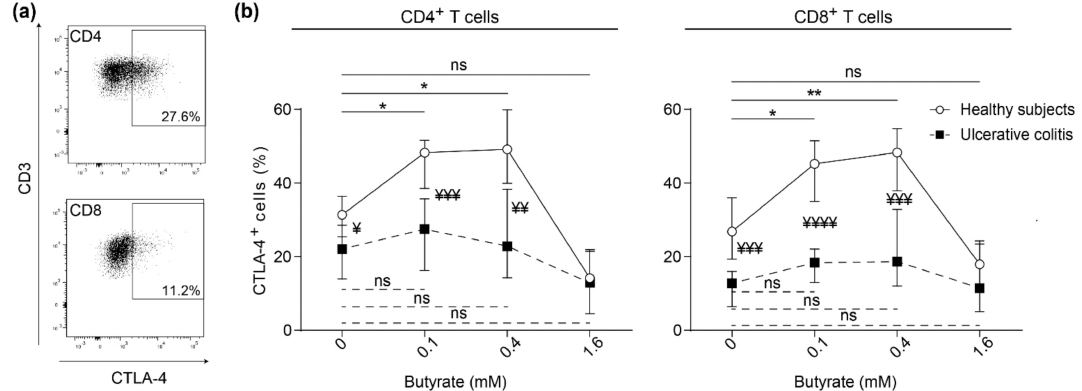
Figure 2. Effects of butyrate on cytotoxic T lymphocyte-associated antigen-4 (CTLA-4) surface expression on blood T cells from healthy subjects and UC patients with active disease. PBMCs were stimulated with anti-CD3 and anti-CD28 with increasing concentrations of butyrate (0–1.6 mM) for 72 h and analyzed by flow cytometry. ( a ) Gating strategy in an active UC patient for CTLA-4 expression on CD4 + (top) and CD8 + (bottom) T cells. ( b ) Frequency of CTLA-4 expressing CD4 + and CD8 + T cells among healthy subjects (open circles, n = 9) and patients with active ulcerative colitis (solid squares, n = 7). Comparisons within healthy subjects (solid lines) and within UC patients (dotted lines) are denoted with * where * < 0.05 and ** < 0.01. Comparisons between healthy subjects and UC are denoted with ¥ where ¥ < 0.05, ¥¥ < 0.01, ¥¥¥ < 0.001 and ¥¥¥¥ < 0.0001. Ns = non-significant. Data are shown as median and interquartile range.